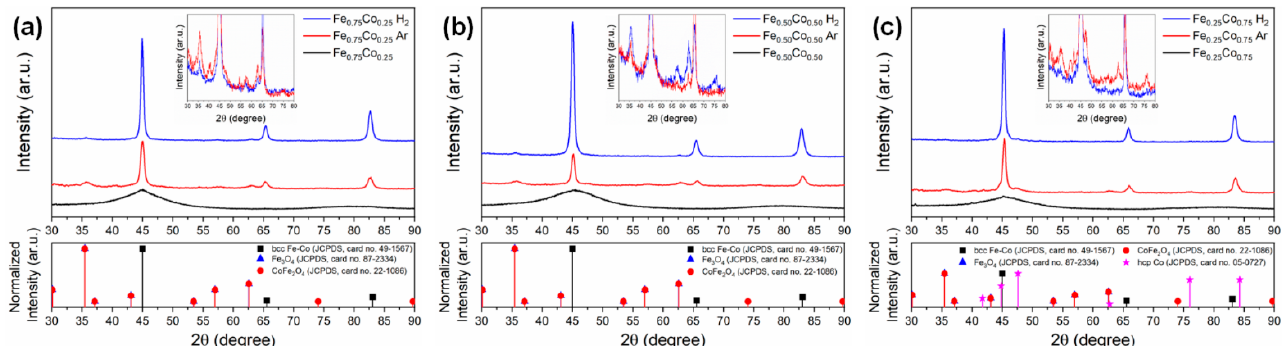
Figure 3. XRD patterns of as-prepared and annealed ( a ) Fe 0.75 Co 0.25 , ( b ) Fe 0.50 Co 0.50 , and ( c ) Fe 0.25 Co 0.75 Wire-like nanochains; the bottom panels indicate the reference positions of the Bragg peaks based on the JCPDS database for the crystalline bcc Fe-Co, Fe 3 O 4 , CoFe 2 O 4 , and hcp Co phases; the insets present the magnified view of XRD patterns associated with oxides in the range between 30 and 80°.